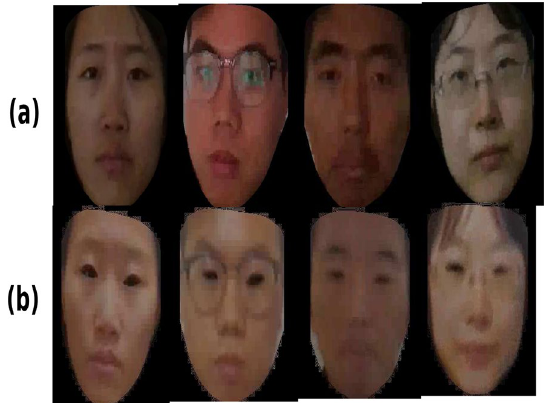
Fig. 16 Examples (both natural and spoof-print versions) from the original CASIA-SURF dataset [32]